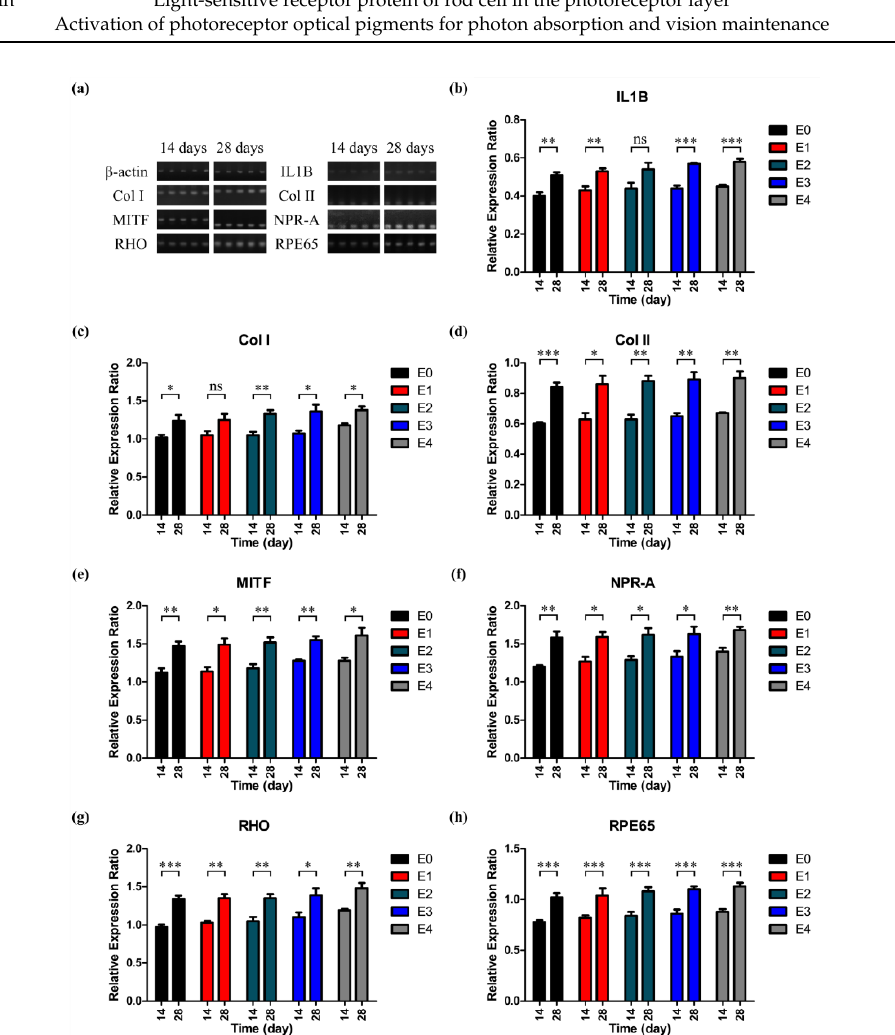
Figure 10. ( a ) The agarose gel images obtained after the electrophoresis of the RT-PCR products. Relative expression ratios of IL1B ( b ), Col I ( c ), Col II ( d ), MITF ( e ), NPR-A ( f ), Rhodopsin ( g ), and RPE65 ( h ) normalized based on the expression of β -actin. p values were analyzed through the one-way ANOVA test and specified as follows: NS (not significant) p > 0.05, * p < 0.05, ** p < 0.01, and *** p < 0.001. Error bars mean the standard deviation (n =